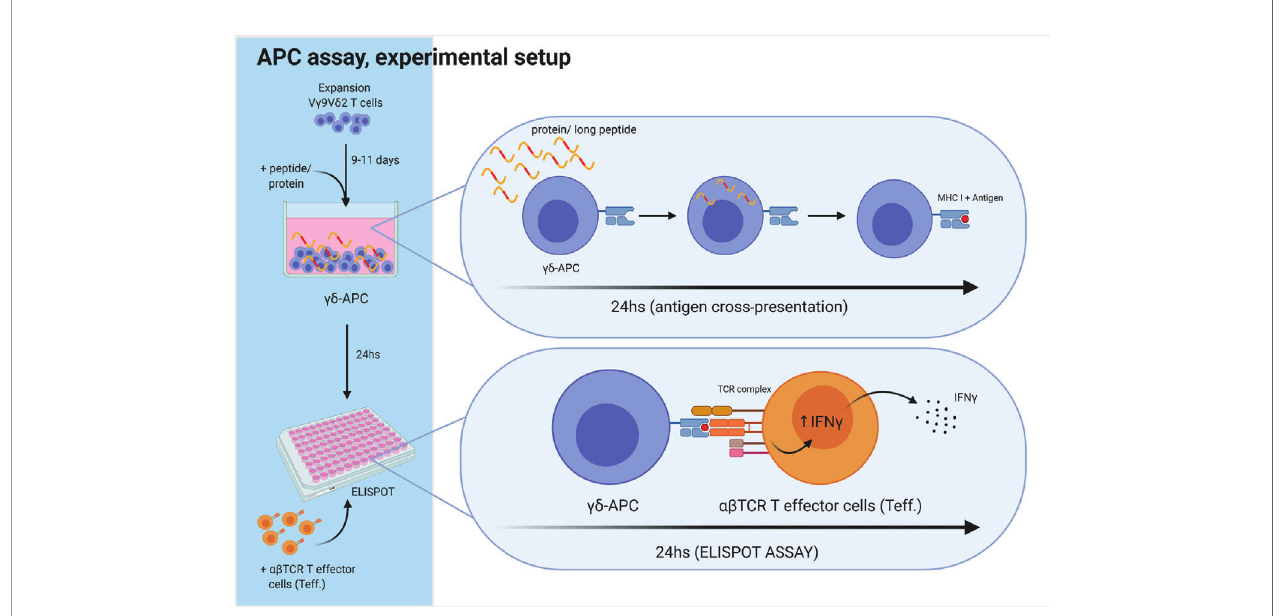
FIGURE 3 | Experimental setup for antigen cross-presenting assay. The ability of V g 9V d 2 T cells to cross-present antigens was tested as schematically outlined. V g 9V d 2 T cells were expanded for 9-11 days, as described in the method section. Next, long peptide or protein was added to wells with V g 9V d 2 T cells, followed by 24 h incubation, to allow antigen uptake and cross-presentation. Then, the V g 9V d 2 T cells were washed twice to remove excess long peptide or protein. Next, V g 9V d 2 T cells were transferred to the ELIPOT plate and antigen speci fi c ab TCR T effector cells (Teff) were added. IFN g secretion following speci fi c target recognition was measured by IFN g ELISPOT assay. V g 9V d 2 T cells alone were used as negative controls. For positive controls, short peptide was added to wells containing both V g 9V d 2 T cells and Teff leading to maximal recognition and associated cytokine secretion by Teff.Figure is created with